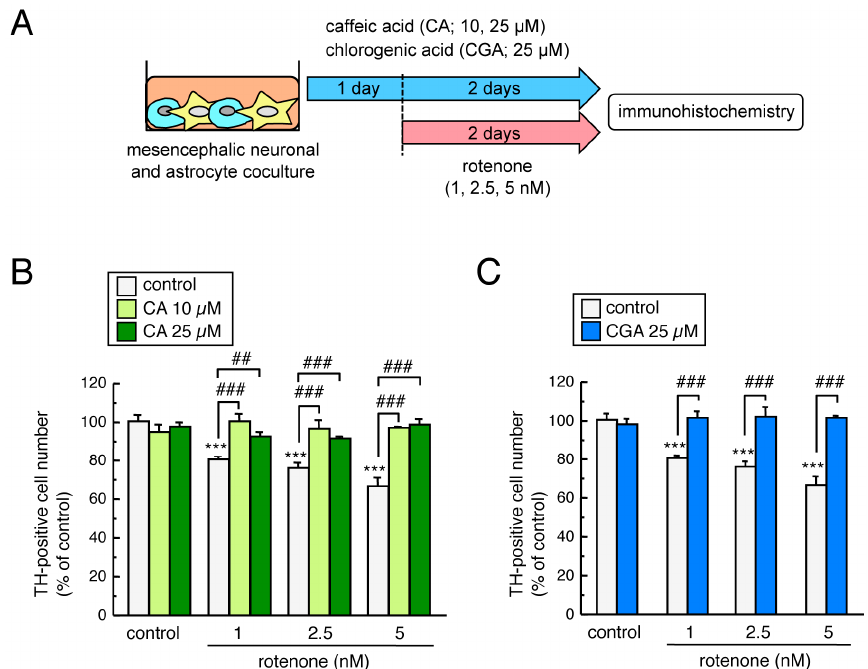
Figure 5. Neuroprotective effects of CA and CGA against rotenone-induced dopaminergic neurotoxicity in cultured mesencephalic cells. ( A ) Schematic illustration of the experimental protocol. Mesencephalic neuronal and astrocyte co-cultures were pretreated with CA (10 or 25 µ M) or CGA (25 µ M) for 24 h and co-treated with rotenone (1–5 nM) for a further 48 h. ( B , C ) Changes in the number of TH-positive neurons after treatment with rotenone and CA ( B ) or CGA ( C ). Data are means ± SEM (n = 4). *** p < 0.001 vs. each control group, ## p < 0.01, ### p < 0.001 between the two indicated groups.